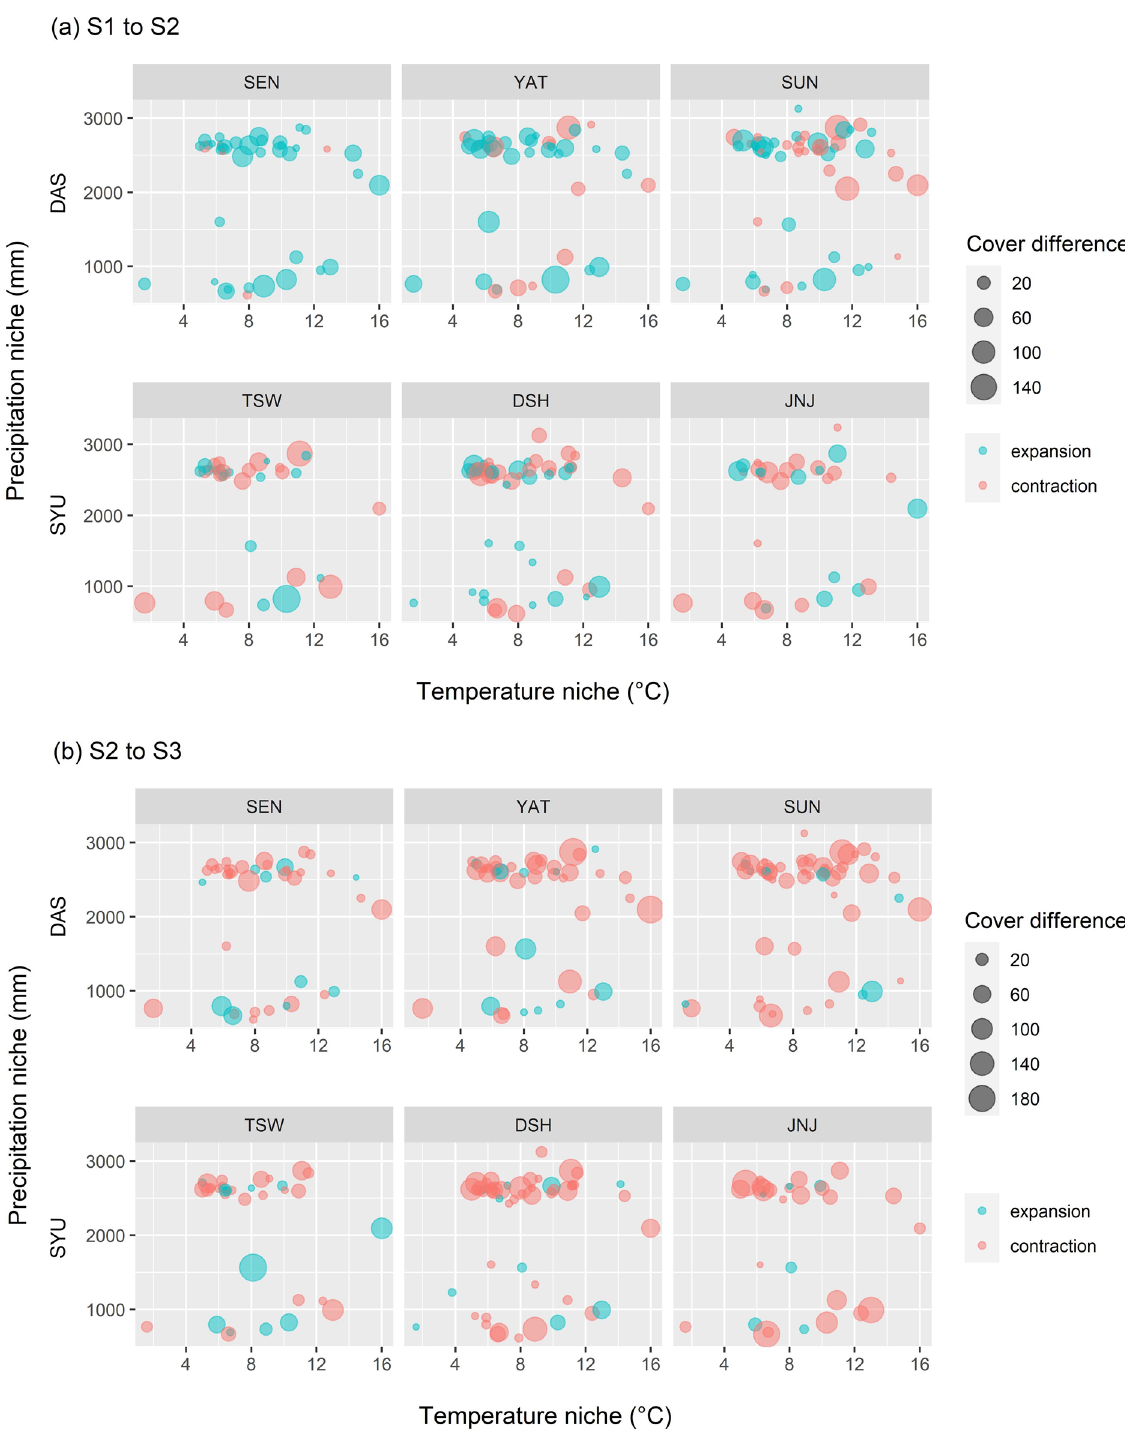
Figure 4. The species climate niche and species cover difference during the three surveys at each summit (summits of the Dashueiku Mountain (DAS) region: SEN, YAT and SEN; the Syue Mountain (SYU) region: TSW, DSH and JNJ), ( a ) from the first survey (S1) to the second (S2), ( b ) from the second survey (S2) to the third